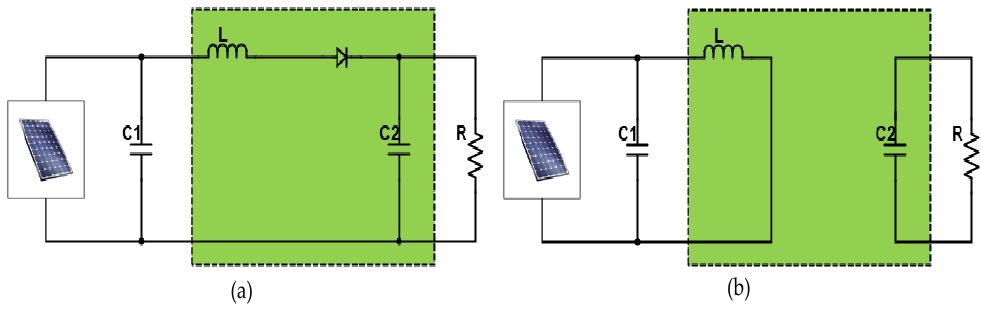
Figure 13. Circuit layout when MOSFET is ( a ) toggled ON or ( b ) toggled OFF.